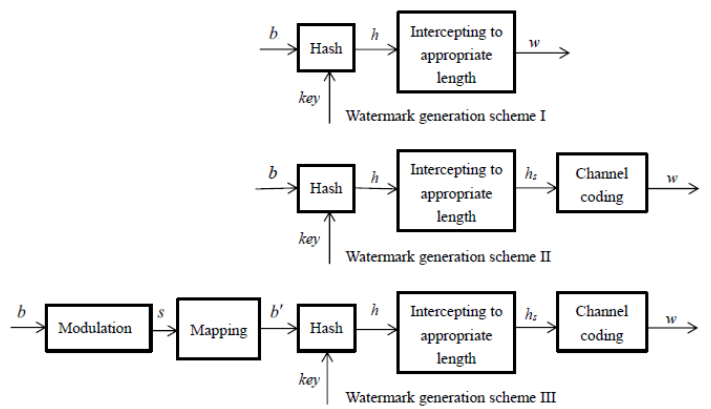
Figure 7. Watermark generation schemes. Scheme I is the basic watermark generation scheme, Scheme II adds channel coding on this basis, and Scheme III uses the pseudo-user-bit instead of the user symbol as the input of the hash algorithm.